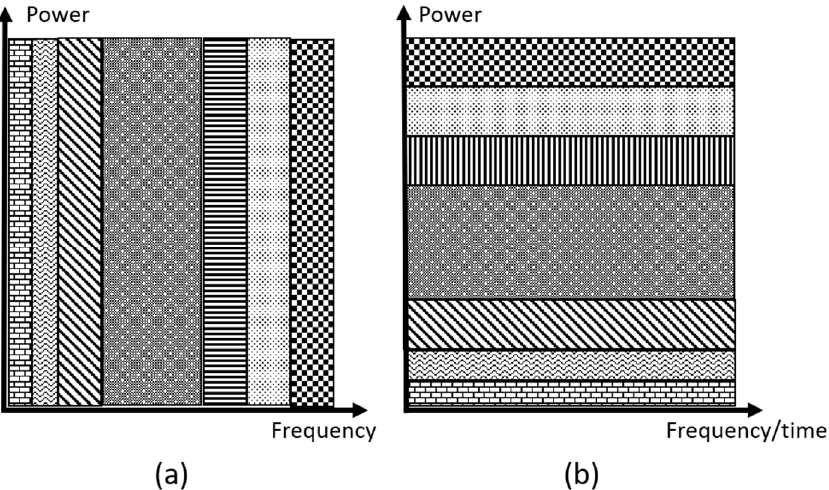
Figure 1. Spectrum sharing and power allocation in ( a ) orthogonal frequency division multiple access (OFDMA) and ( b ) non-orthogonal multiple access (NOMA).